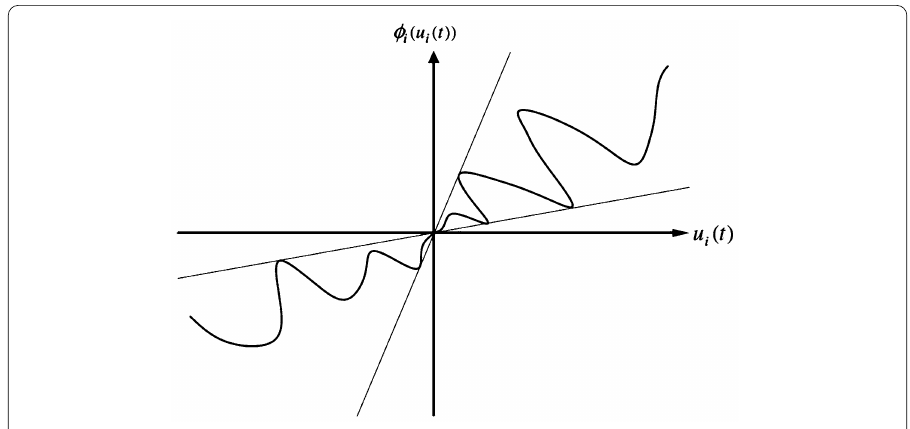
Figure 1 A schematic diagram of a typical input